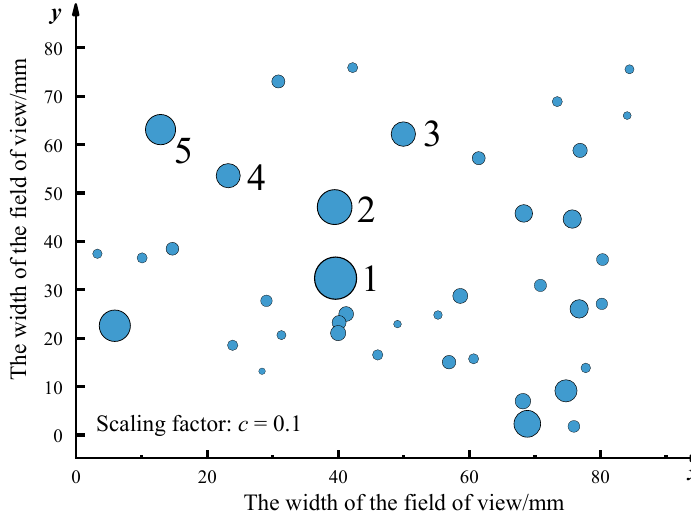
Figure 7. Defect size statistics and distribution.